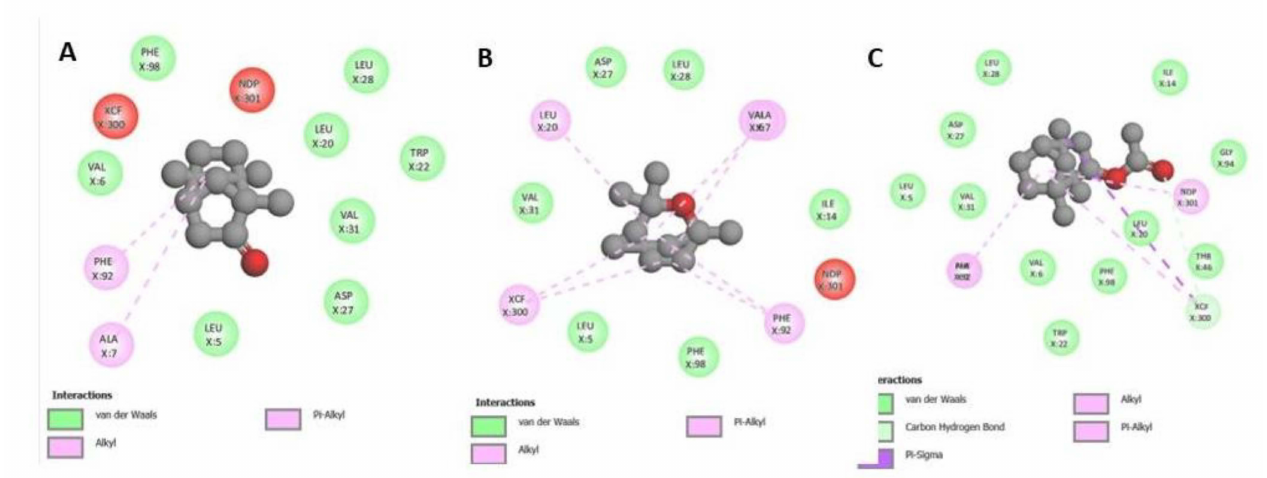
Figure 4. 2D scheme of DNA gyrase interaction with the tested ligands ( A ) Eucalyptol; ( B ) Camphor; ( C ) Bornyl acetate.